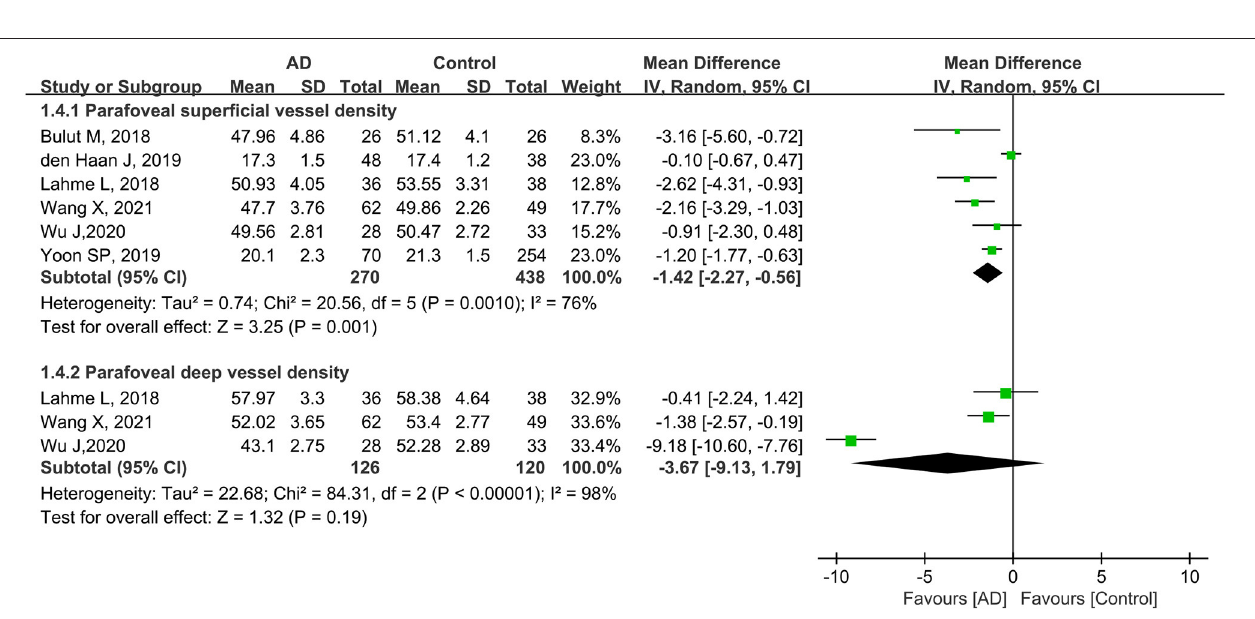
patients with AD and 97 eyes in controls). Compared to controls, − 2.37 to 0.41, P = 0.17, Figure 7 ) with moderate heterogeneity across the studies (chi 2 = 6.43, P = 0.04, I 2 = 69%, Figure 7 ). Only one eligible study reported parafoveal deep VD using a 6 × 6-mm scan in 61 eyes (28 eyes in patients with AD and 33 eyes − 7.76, P < 0.00001, Figure 7 ), revealing that the parafoveal